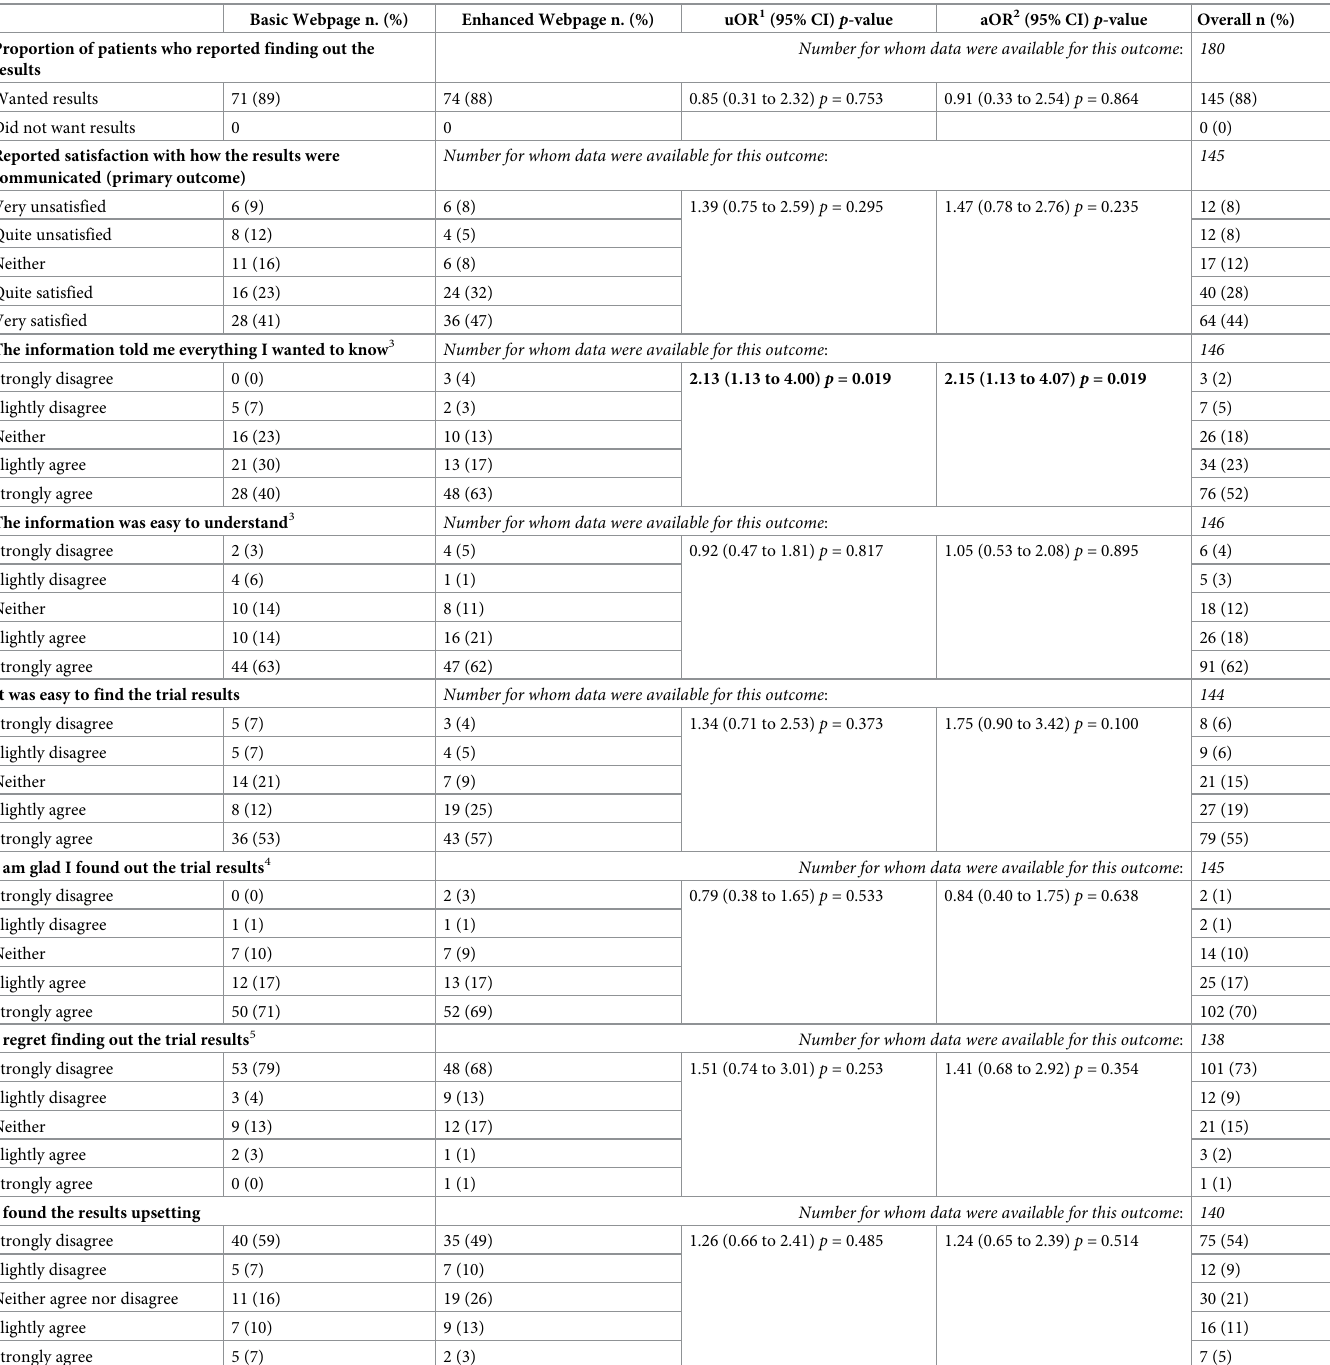
Table 4. Reported outcomes relating to experience of receiving the results by randomised intervention: Enhanced versus Basic Webpage. Basic Webpage n.